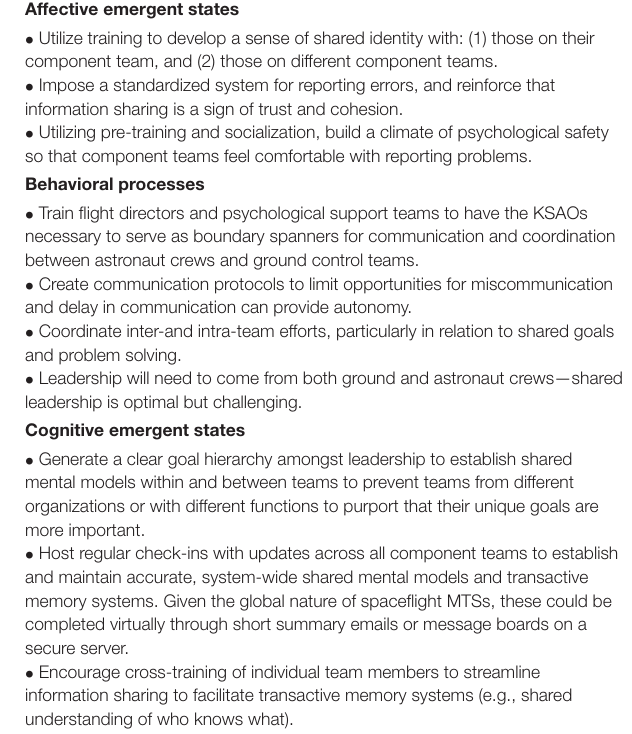
TABLE 2 | Practical recommendations identified in operational assessments relevant to spaceflight